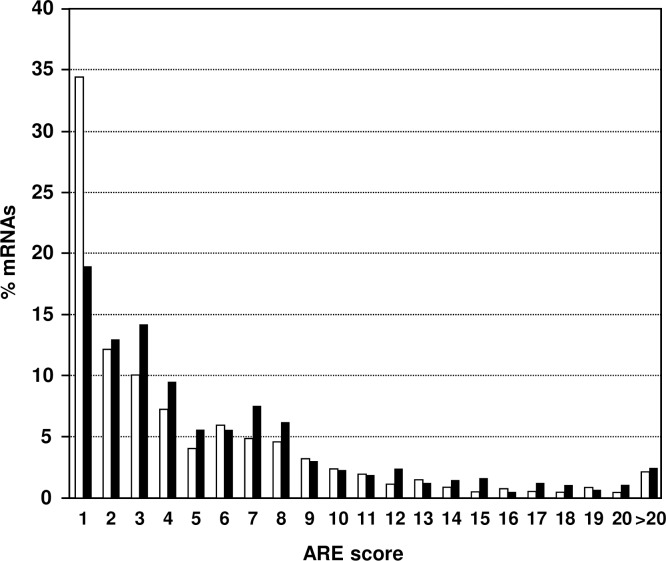
Assessment of AREScore.The 508 AUF1 p42 bound mouse mRNAs that were more than 3-fold enriched on microarrays (black bars) were analyzed by the algorithm of AREScore [38] and compared to 800 non-enriched mRNAs (white bars). Frequencies of ARE scores between 1 to 20 and >20 were plotted.